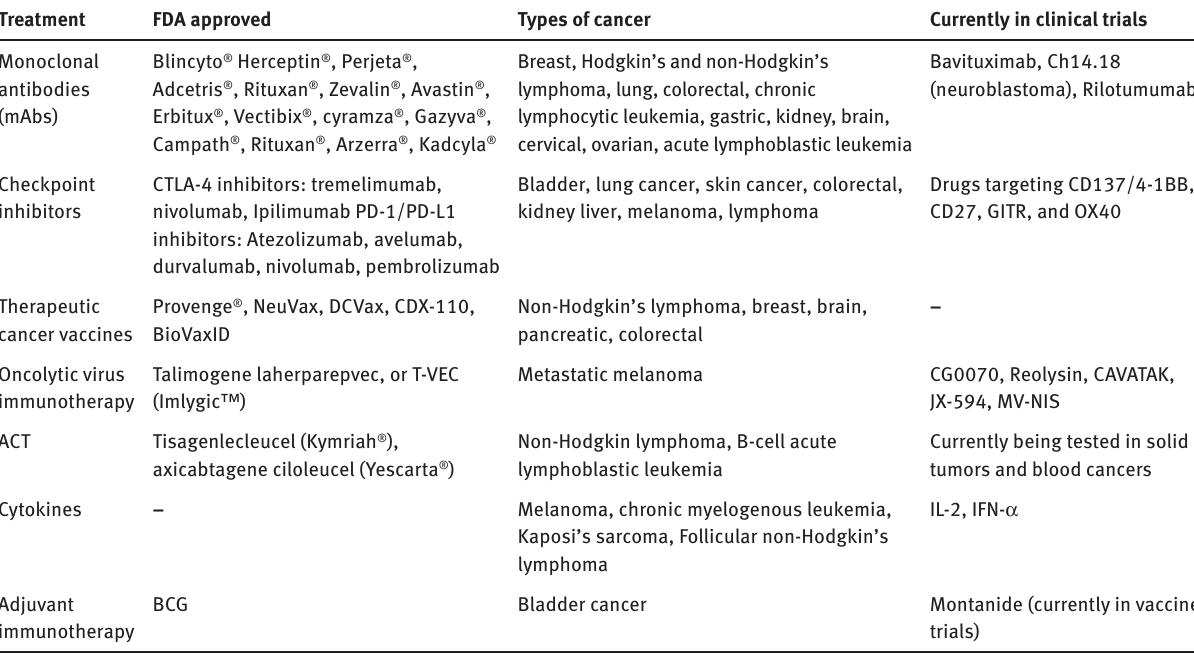
Table 3: Different types of immunotherapies under clinical trials [16, 117].